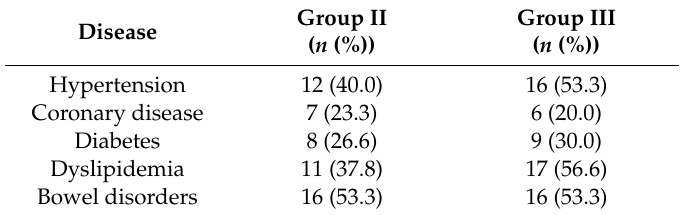
Table 2. Somatic diseases in elderly patients without (group II) and with (group III) mood disorders.